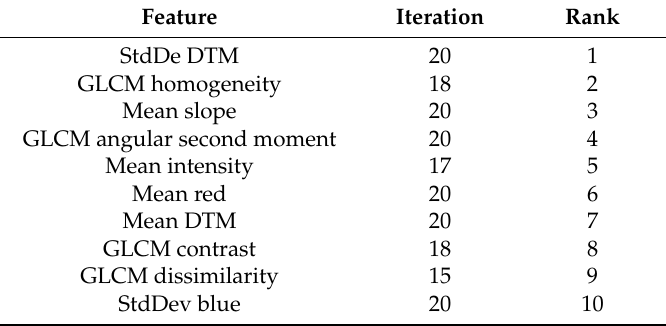
Table 4. Correlation-based feature selection (CFS) results for the most relevant feature subset at a scale of 75.52; StdDe: Standard deviation, DTM: Digital terrain model, GLCM: Gray level co-occurrence matrix. Feature Iteration Rank StdDe